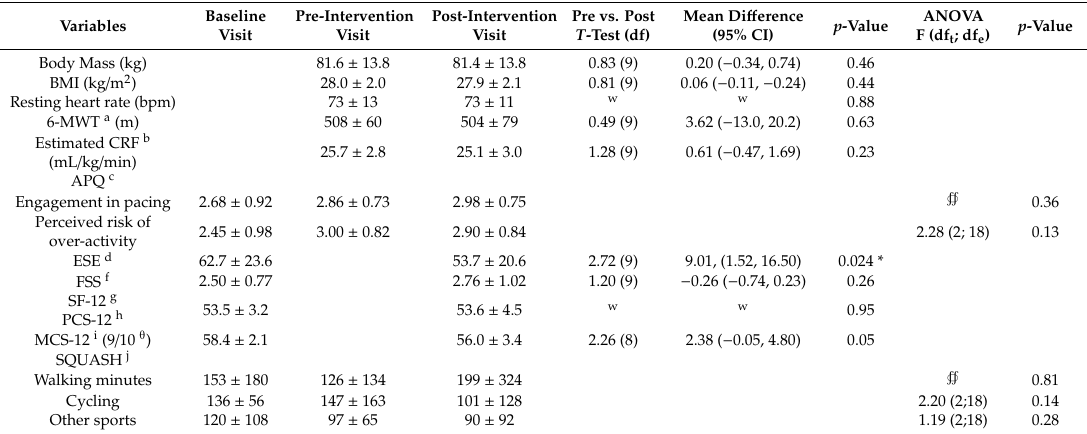
Table 2. Baseline, pre-, and post-intervention values.